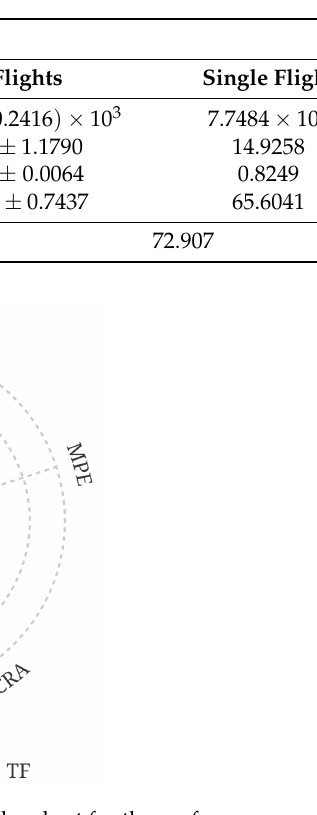
Table 8. Performance of the RUL prediction for the next 128 s.